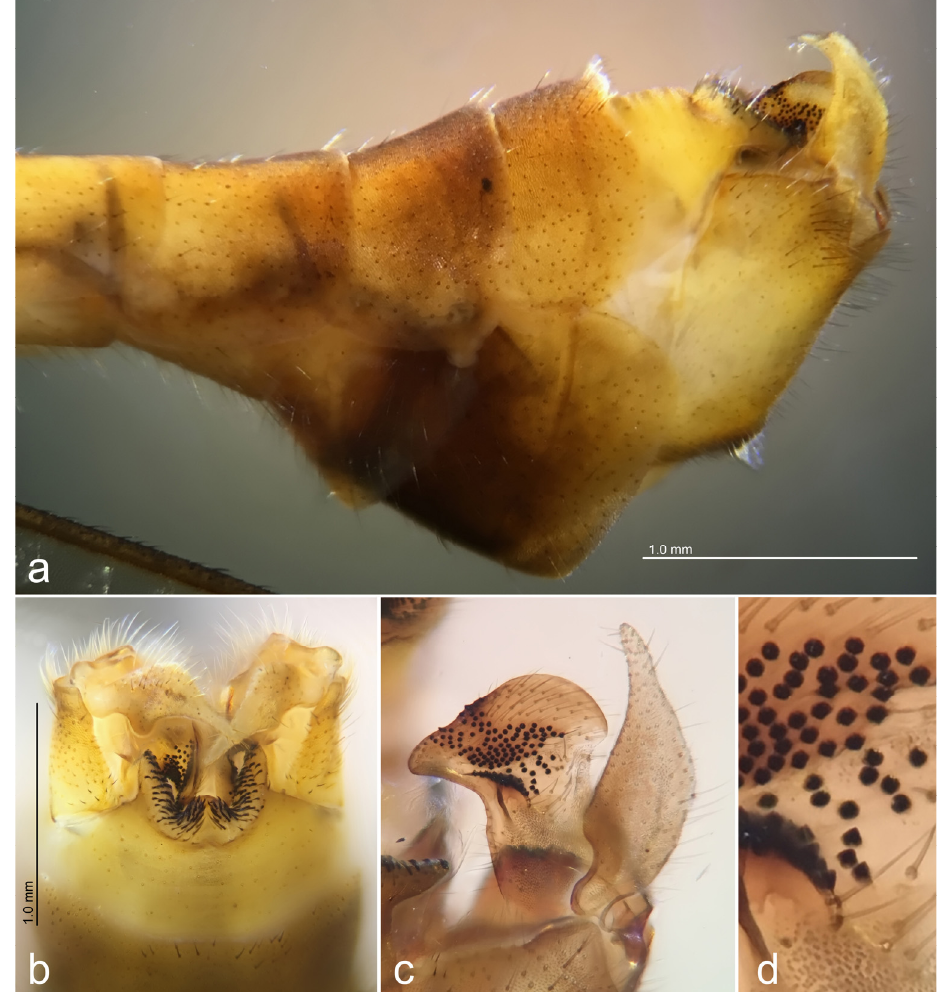
Figure 9. Zelandotipula gelhausi sp. nov., holotype male; ( a ) Terminalia, lateral view; ( b ) Tergite 9, dorsal view; ( c ) Outer and inner gonostyli, lateral view; ( d ) Detail of the blackened nodules on the inner gonostylus.